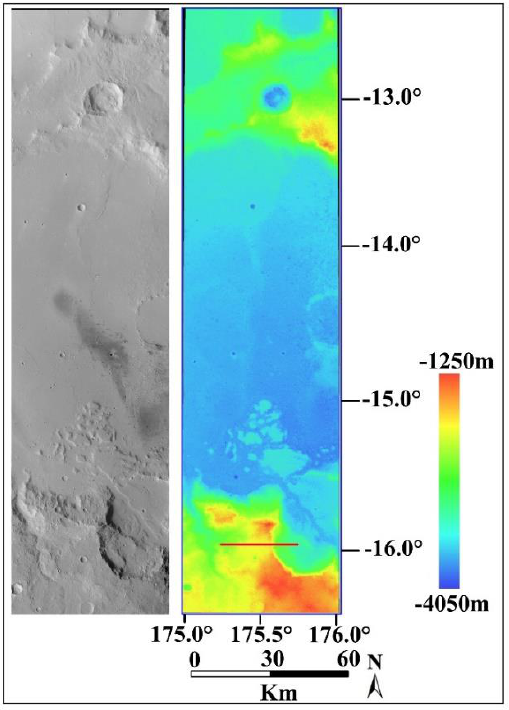
Figure 2. The DOM and DTM results generated from MEX HRSC images. The red solid line indicates the positions of sampled points for plotting terrain profile.